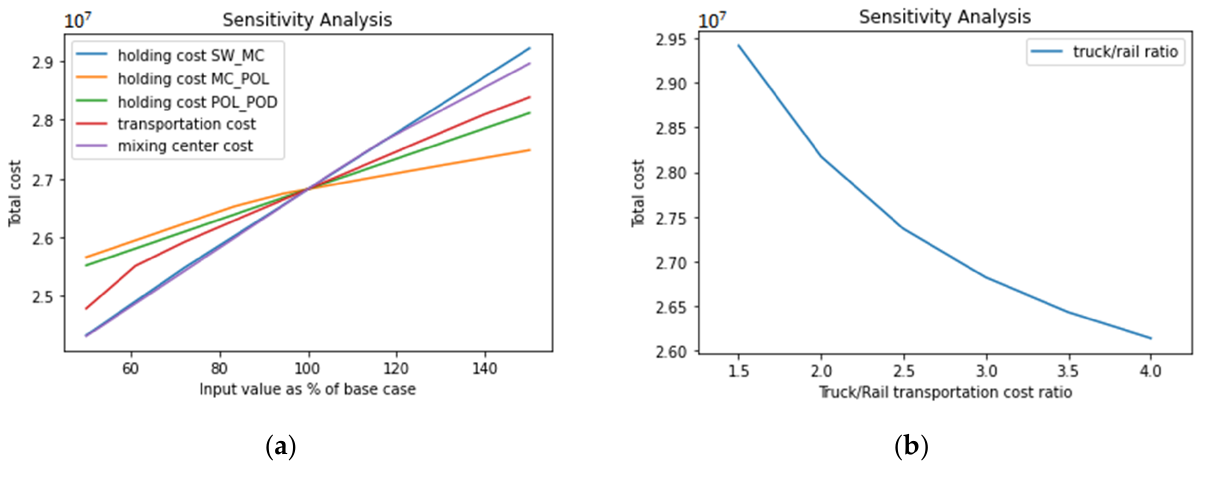
Figure 5. ( a ) Sensitivity analysis of holding costs, transportation cost, mixing center cost; ( b ) sensitivity analysis of truck-to-rail transportation cost ratio.